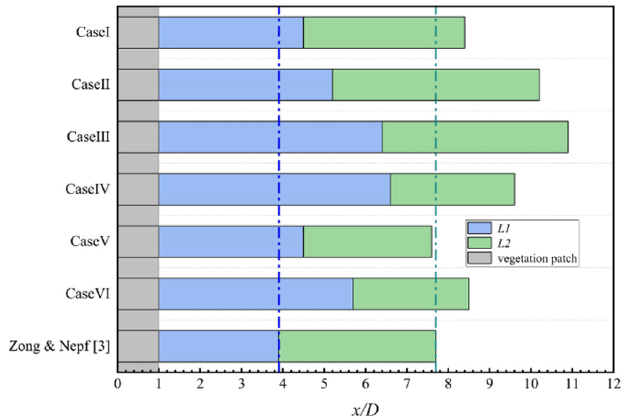
Figure 8. The lengths of the wake segments obtained from the cases and experiments of Zong and Nepf are illustrated [3]; blue indicates the stable wake segment, and green indicates the wake recovery segment; the blue and green dashed line indicates the L 1 and L 2 of experiments. The gray part indicates the internal area of vegetation patches.